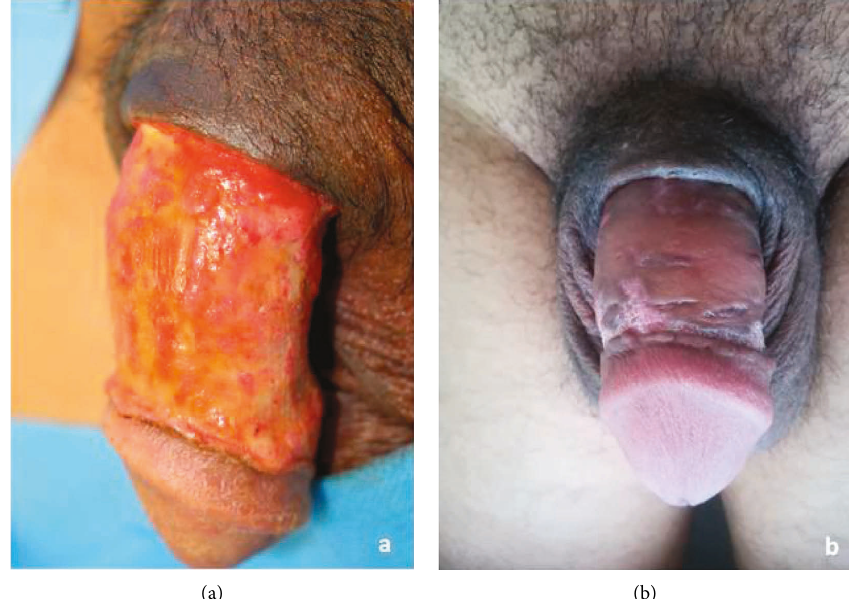
Figure 4: (a) Preoperative vision after debridement of the penis for local infection secondary to a subcutaneous injection of petrolatum. (b) 6 months postoperative result of a full-thickness skin graft for penile